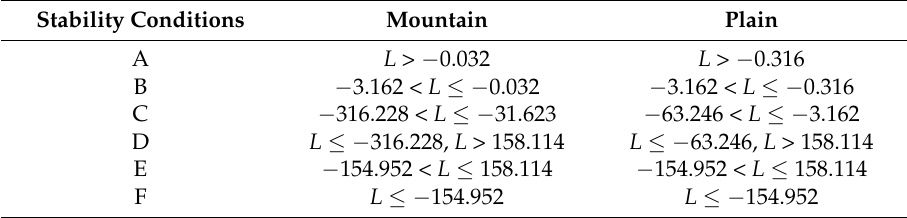
Table 4. Classification of stability based on L in different